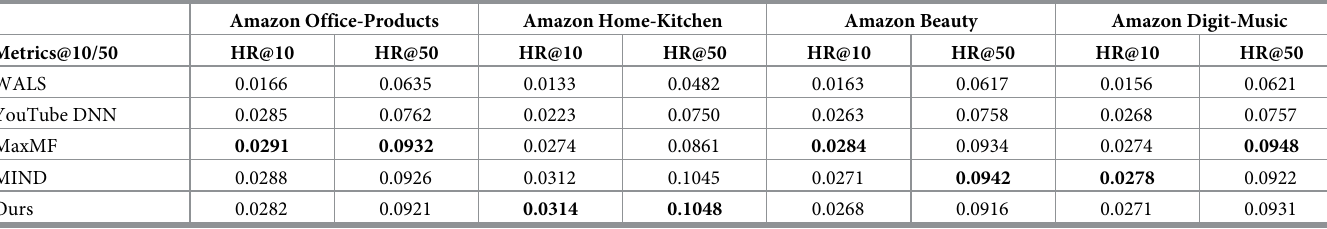
Table 4. Performance comparison of different models on other Amazon